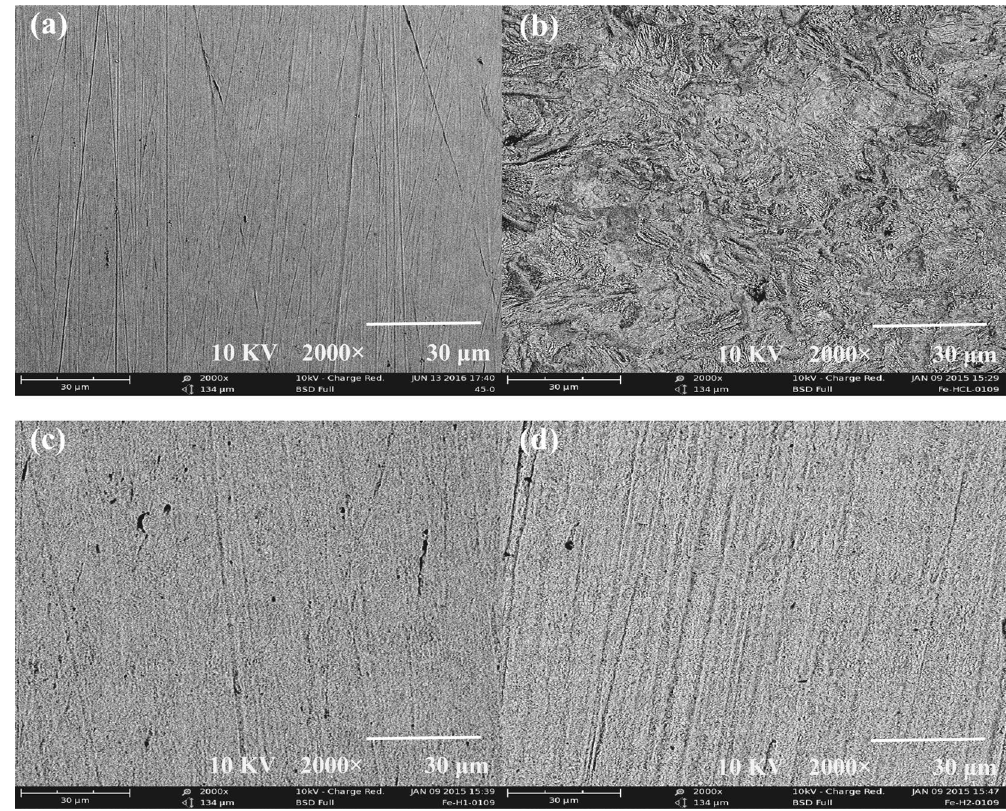
Figure 6. SEM micrographs of the steel surface with the magnification of 2000: fresh surface ( a ); after electrochemical tests in 0.5 M HCl solution ( b ); after electrochemical tests in 0.5 M HCl solution with 0.75 mM BAIL1 ( c ); after electrochemical tests in 0.5 M HCl solution with 0.75 mM BAIL2 ( d